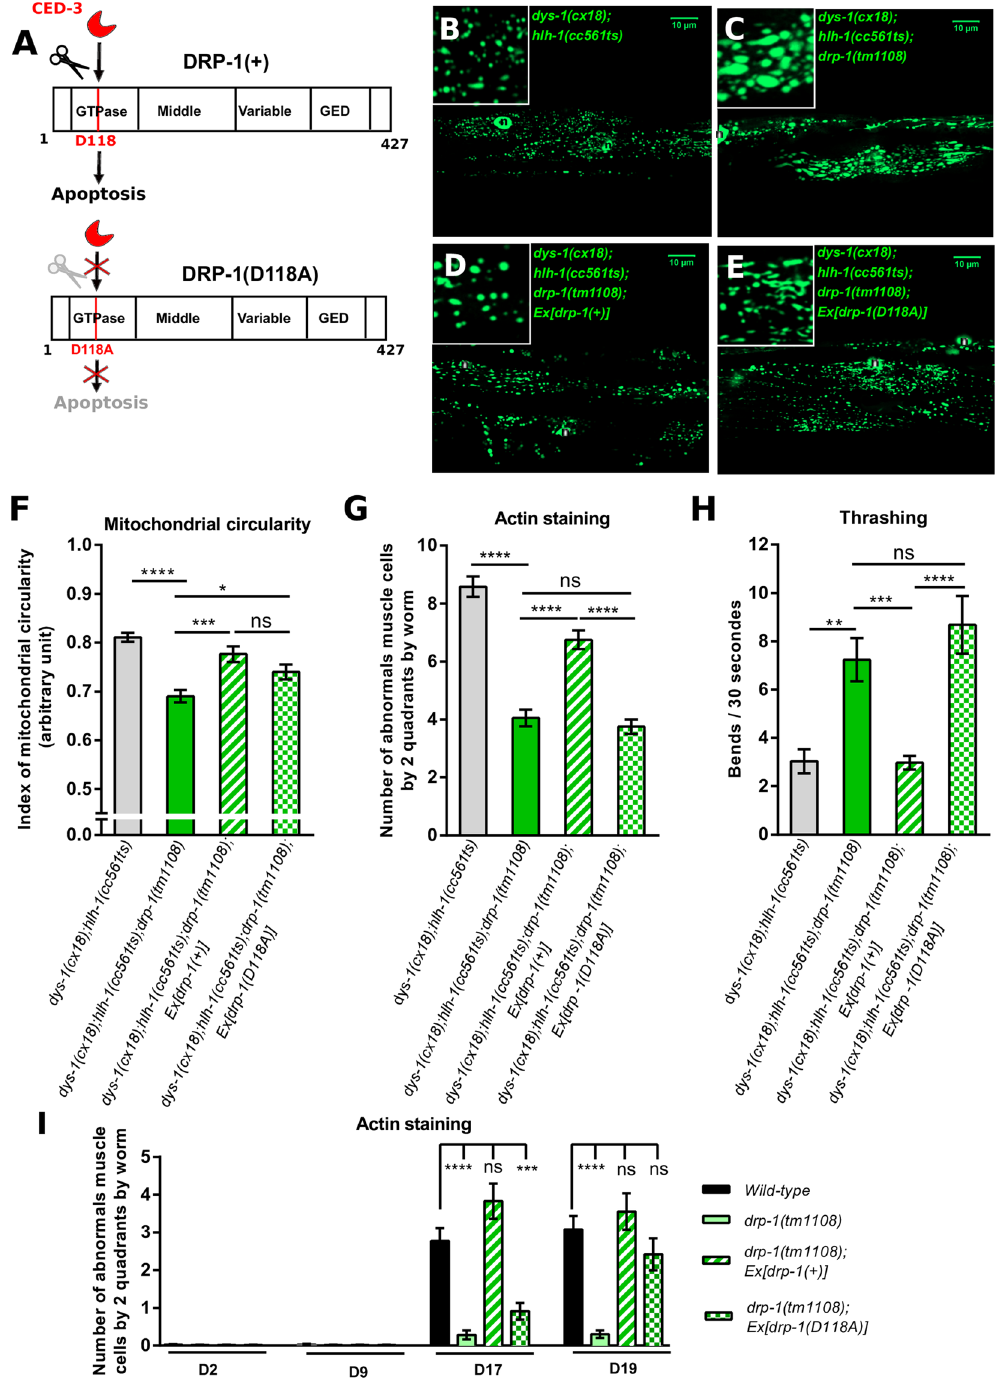
Figure 3. Cleavage of DRP-1 by CED-3 is required for dystrophin-dependent muscle degeneration but is dispensable for regulating mitochondrial fission. ( A ) Schematic representation of the wild-type DRP-1 construct (DRP-1( + )) and of the DRP-1 construct with CED-3 cleavage site mutated due to a change of amino acid D118A (DRP-1(D118A)). The wild-type DRP-1 construct DRP-1( + ) is supposed to play a role in mitochondrial dynamics and in apoptosis, whereas the DRP-1 construct with D118A mutation DRP-1(D118A) is likely to be dispensable for apoptosis 31 . Representative confocal images of the mitochondrial network organization visualized with the ccIs4251 transgene in C. elegans body wall muscle cells of: ( B ) dys-1(cx18);hlh- 1(cc561ts) mutant worms; ( C ) dys-1(cx18);hlh-1(cc561ts);drp-1(tm1108) mutant worms; ( D ) dys-1(cx18);hlh- 1(cc561ts);drp-1(tm1108) mutant worms expressing drp-1 ( + ) and ( E ) dys-1(cx18);hlh-1(cc561ts);drp-1(tm1108) mutant worms expressing drp-1(D118A) . Scale bar 10 μ m. (x630). n indicates nuclei. ( F ) Quantification of mitochondrial circularity in each of the indicated strains (n = 30 worms at least). ( G ) Number of abnormal C. elegans body wall muscle cells by two quadrants quantified by phalloïdin staining in each of the indicated